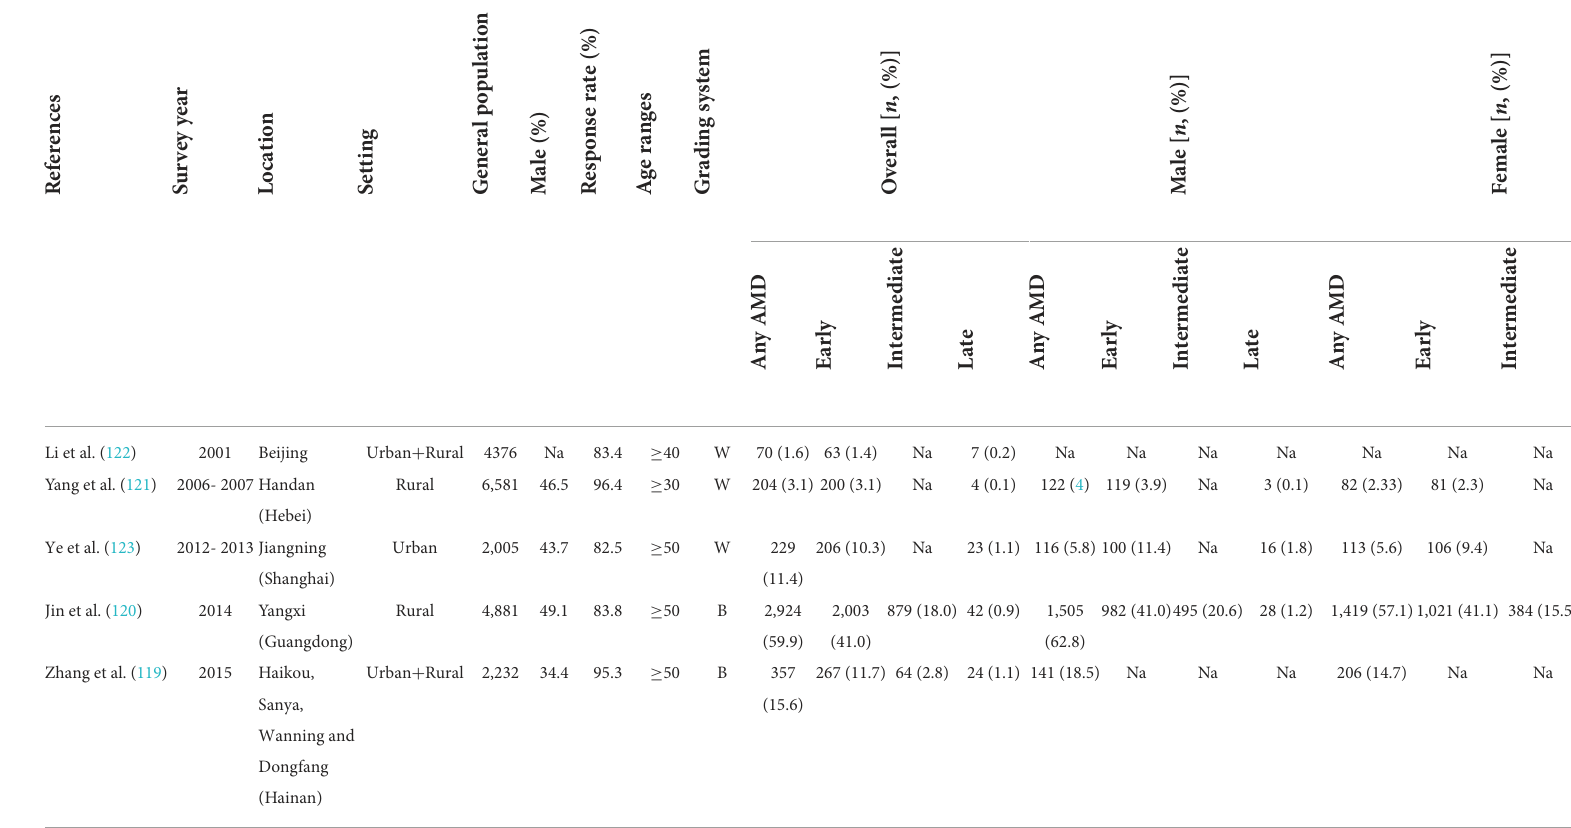
TABLE 4 Detailed characteristics of the main studies on AMD prevalence in mainland